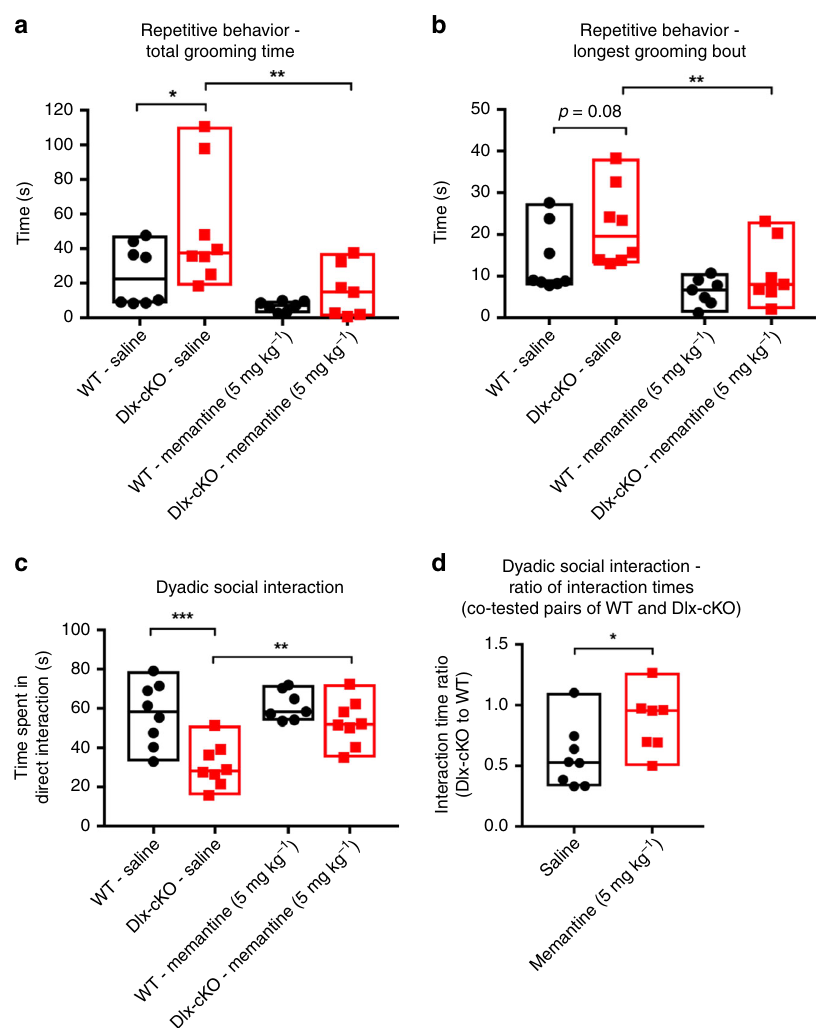
Fig. 5 Acute NMDAR blockade ameliorates autistic-like features in Dlx-cKO mice. a Total grooming in a home-cage like environment is signi fi cantly increased in saline-treated Dlx-cKO mice in comparison to WT, and memantine at 5 mg kg − 1 signi fi cantly rescued the increased grooming phenotype in Dlx-cKO mice ( n = 8 for saline groups; n = 7 for memantine groups; one-way ANOVA with Holm-Sidak ’ s multiple comparisons test). b Memantine signi fi cantly reduces the duration of the longest grooming bout in Dlx-cKO mice. c On the dyadic social assay, saline-treated Dlx-cKO mice spend signi fi cantly less time initiating social interaction with a novel stimulus mouse in comparison to WT. Memantine at 5 mg kg − 1 resulted in a signi fi cant increase in time spent in social interaction ( n = 8 for saline groups; n = 7 for WT — memantine; n = 8 for Dlx-cKO — memantine; one-way ANOVA with Holm-Sidak ’ s multiple comparisons test). d For co-tested pairs of Dlx-cKO and WT mice, the ratio of time spent in direct interaction was signi fi cantly reduced in saline-treated mice. Memantine normalized this ratio, indicating a differential effect of this drug on social interaction in WT and Dlx-cKO mice ( n = 7 for all groups; unpaired t -test). * p < 0.05, ** p < 0.01, and *** p < 0.001. Source data are provided as a Source Data fi